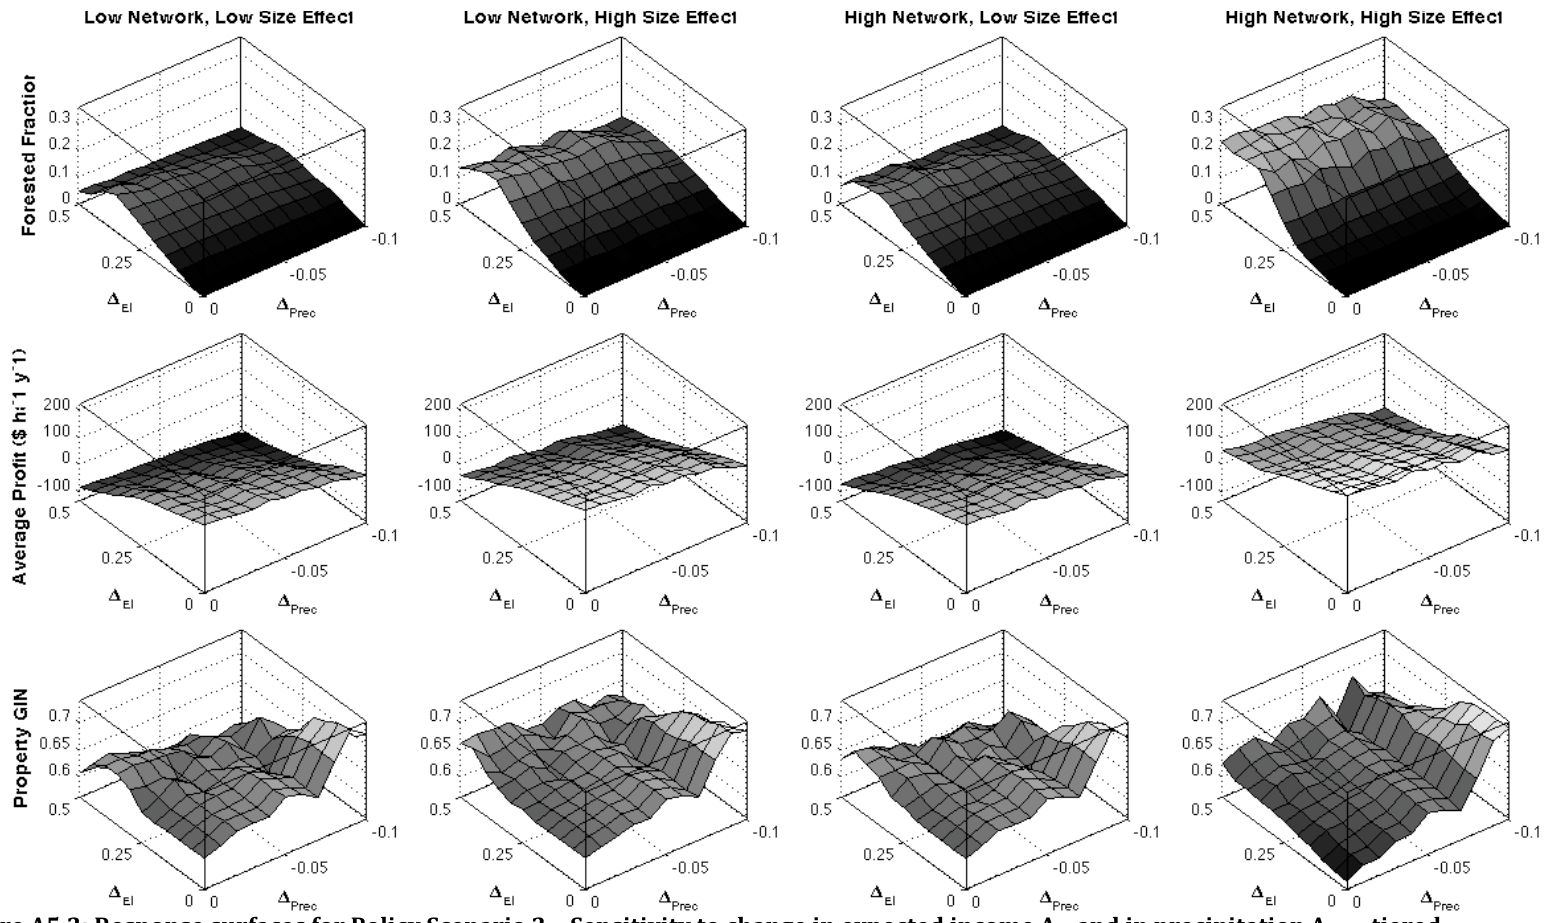
Figure A5.2: Response surfaces for Policy Scenario 2 – Sensitivity to change in expected income Δ EI and in precipitation Δ Prec , tiered environmental licensing. Surfaces in row 1 show average forested fraction across the landscape; row 2 shows average profit per hectare of property per year; row 3 shows the level of land aggregation measured by the property GINI coefficient. Each column represents a different scenario of rancher